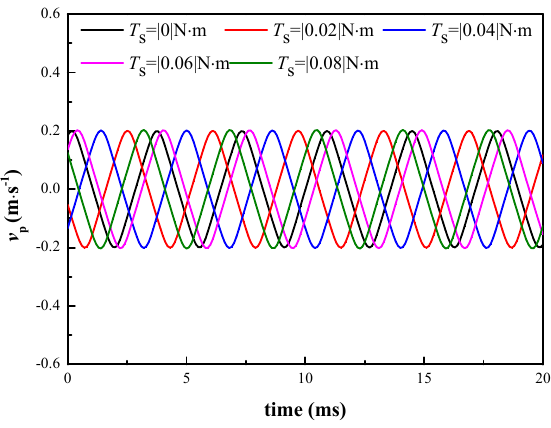
Figure 29. Displacements of different transient flow torques.